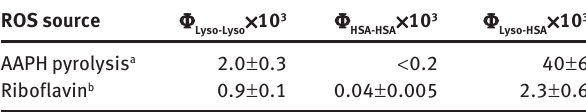
a Values represent the rate of protein modification/rate of peroxyl radical production. b Photosensitized processes induced by ribofla- vin irradiation.